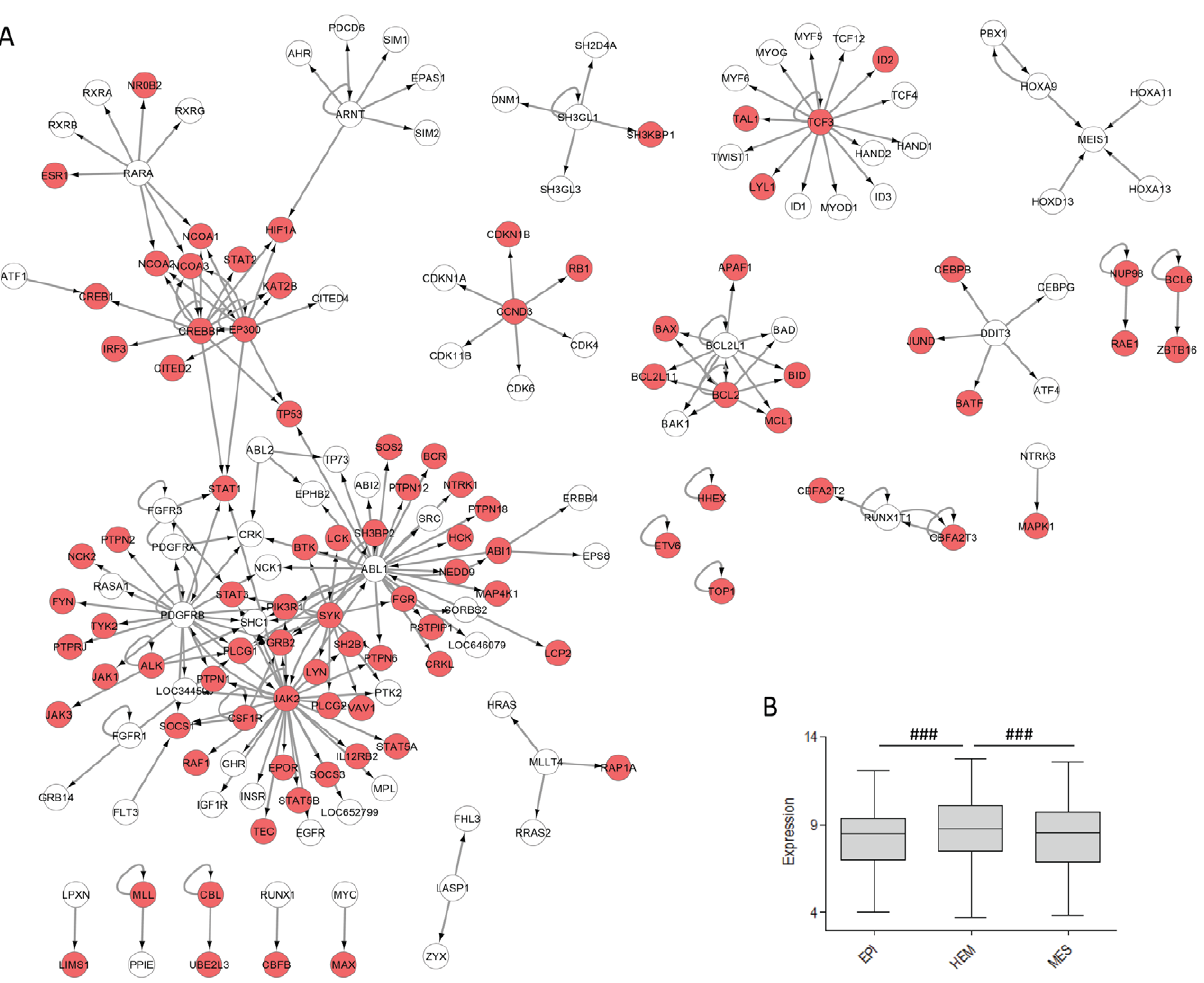
Figure 8. Analysis of interaction partners of 3 9 TPGs. A : Network of protein interaction interfaces (PIIs) retained by 3 9 TPGs and their interaction partners. Edges point from a 3 9 TPG towards its interacting proteins. Red nodes indicate genes that are on average more expressed in hematopoietic than in non-hematopoietic samples. B : Expression of interacting partners in tissues of epithelial (EPI), hematopoietic (HEM) and mesenchymal (MES) lineage. If multiple 3 9 TPGs have the same interacting protein, it is included the corresponding number of times. ### - p , 0.001, Wilcoxon signed rank test.